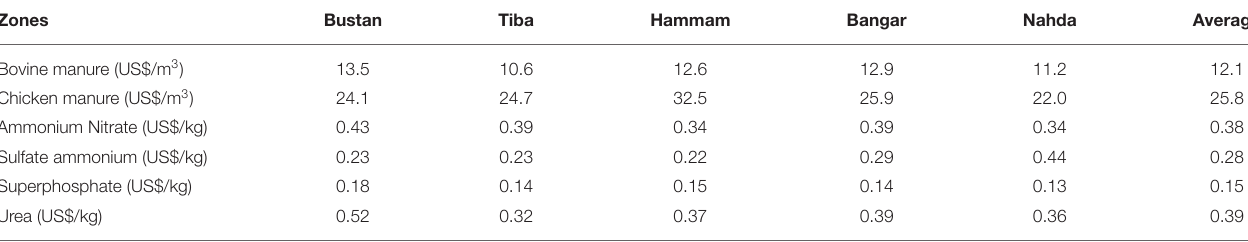
TABLE 3 | Unit purchased price of organic and mineral fertilizers (in US$). Zones Bustan Tiba Hammam Bangar